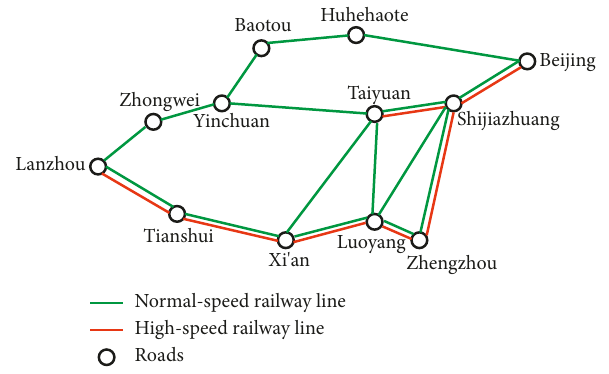
Figure 7: Simplified Lanzhou-Beijing road network map under syncretic railway Table 4: Direct routes search results.